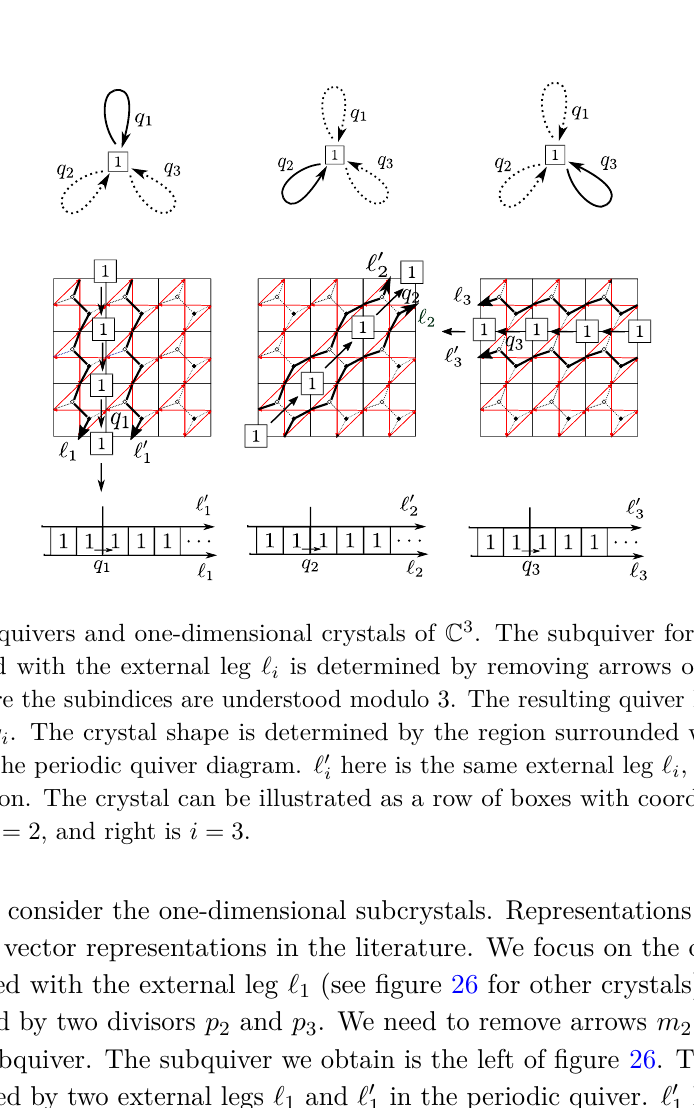
= i − 1 ∪ m i +1 , but in a different i . Left is i